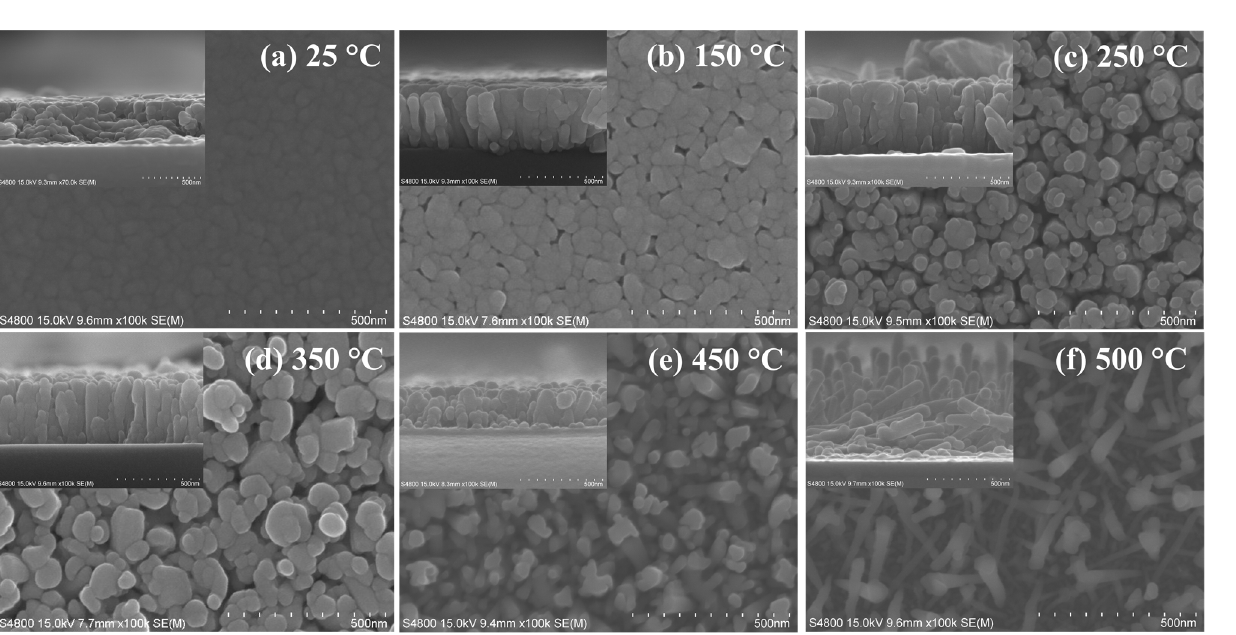
Table 2. Values of the variation in the chemical composition of CdS thin films grown at various substrate